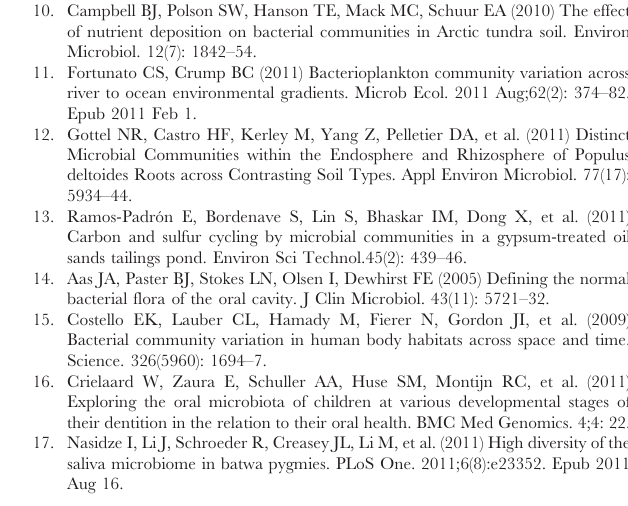
defined as any taxa with abundance greater than 1% (blue). The rare taxonomic units tend to outnumber the common taxonomic units although their proportion of abundance is low. Figure S2 Bootstrapped instance of rarefaction curve and resultant fitted curves. This is an example of a resultant curve fit for keratinized gingiva using OTUs for a single instance of bootstrapping. Bootstrapping the sequence of donors was necessary to generate a median and 95% confidence intervals for S max, for each body site. From this methodology, it is possible to compare various models by looking at the Root Mean Square Deviation (RMSD) outcomes. The smaller the RMSD, the better the fit. Table S1 Wilcoxon Rank Sum Test P-values for body region differences. The null hypothesis is row body regions are less than or equal to the column body regions. The alternative hypothesis is that the row body regions are greater than the column body regions. For example, looking at genera-based taxonomic units for the Shannon diversity, the oral body region had significantly greater diversity than the vaginal body region, p- value = 0.0045 with an a of 0.05. Statistically significant differences are highlighted in blue. P-values were not corrected for multiple comparisons. Table S2 Mapping of body habitat to abbreviations. Table S3 Sampling and read depths across body